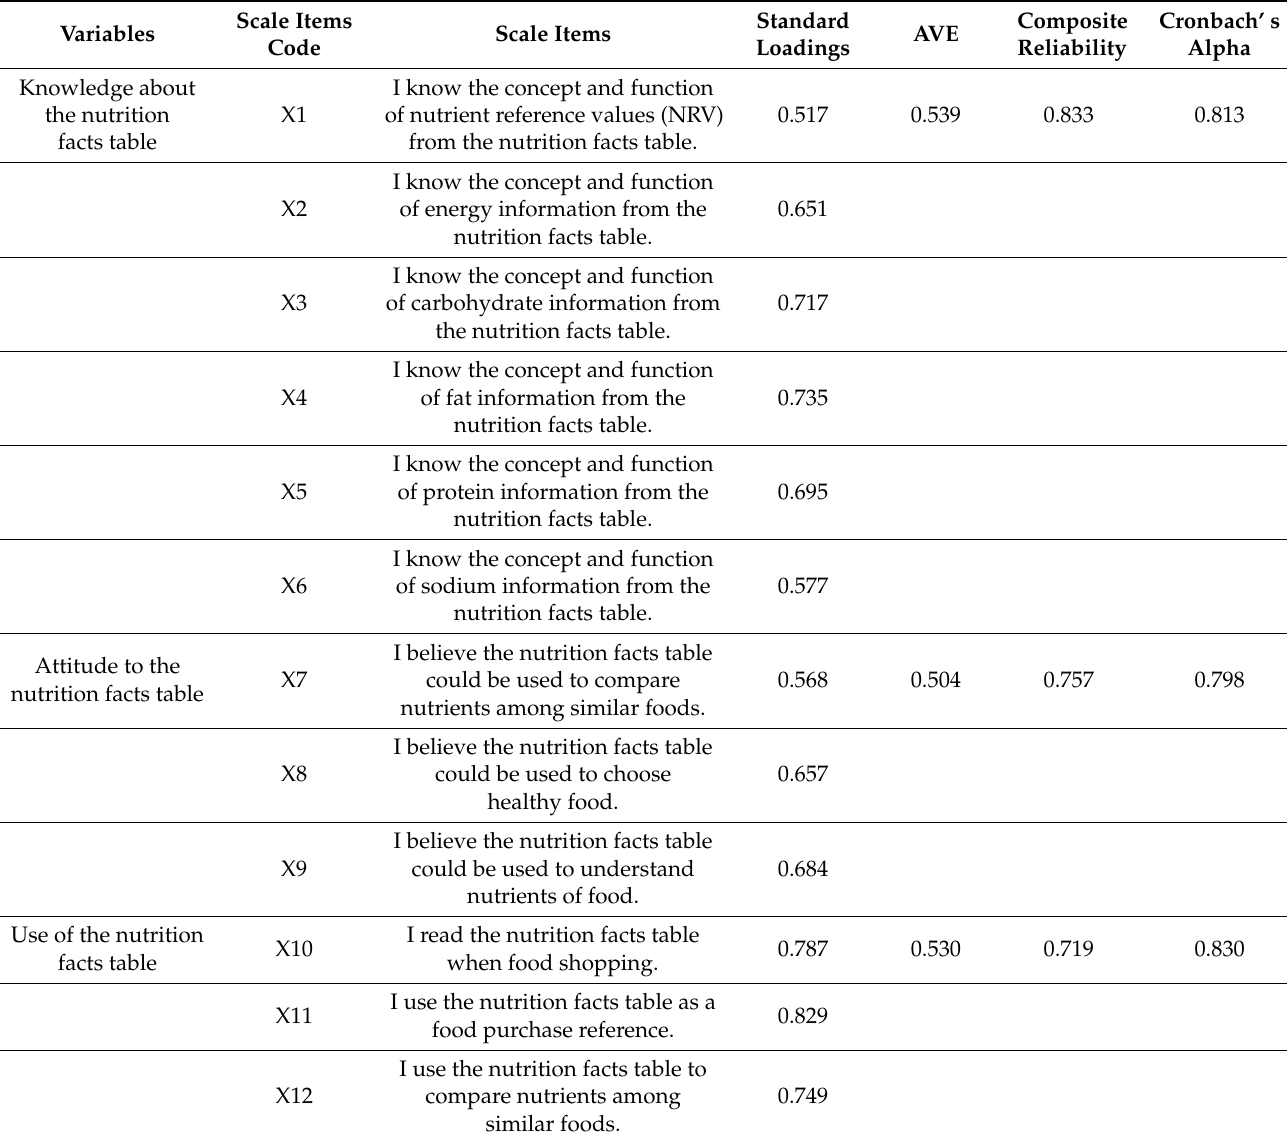
Table 5. Factor loadings and convergent validity